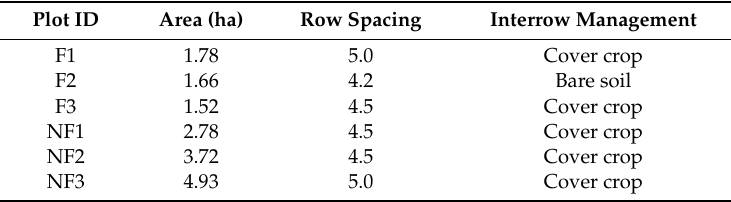
Table 1. Characteristics of the sample